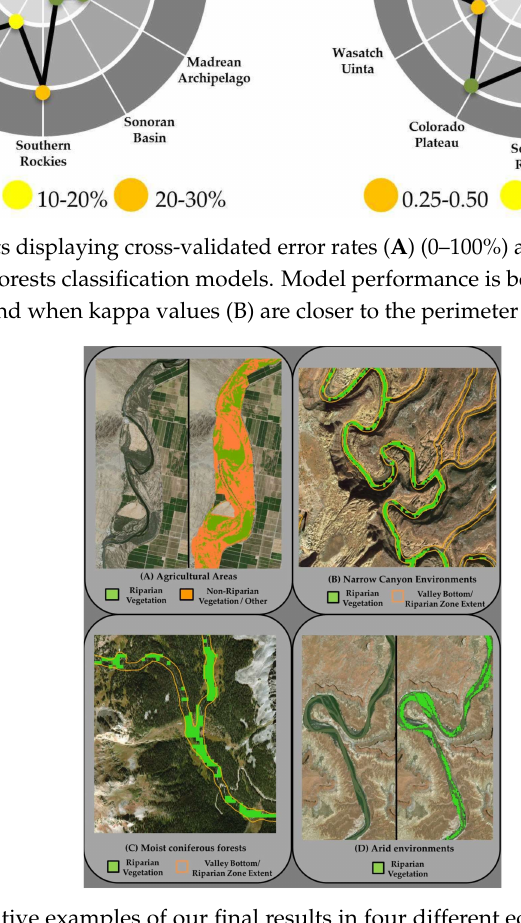
Figure 6. Representative examples of our final results in four different ecoregions. ( A ) Displays the differentiation of agriculture from riparian vegetation and the delineation of the riparian